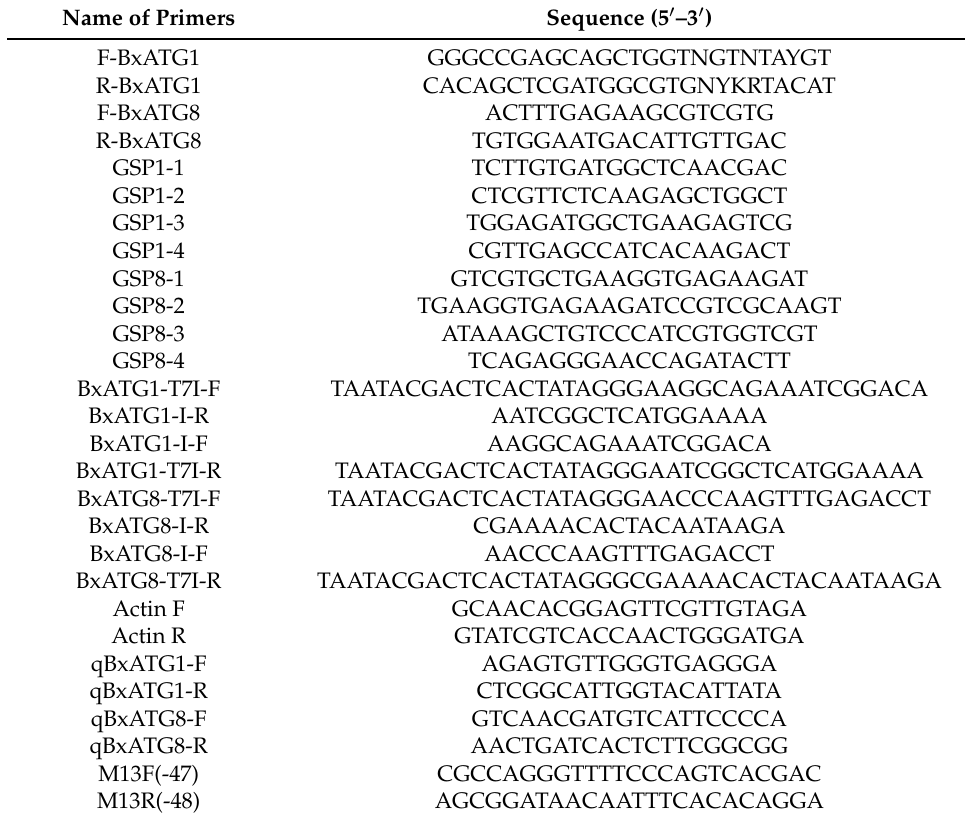
Table 1. Polymerase chain reaction (PCR) primers used in the